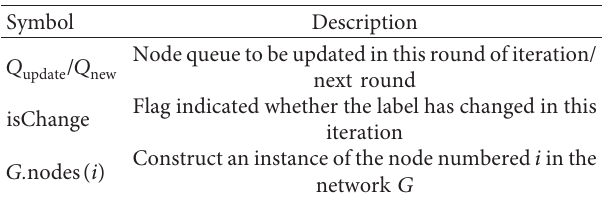
Table 2: Symbols of Algorithm 1. Symbol